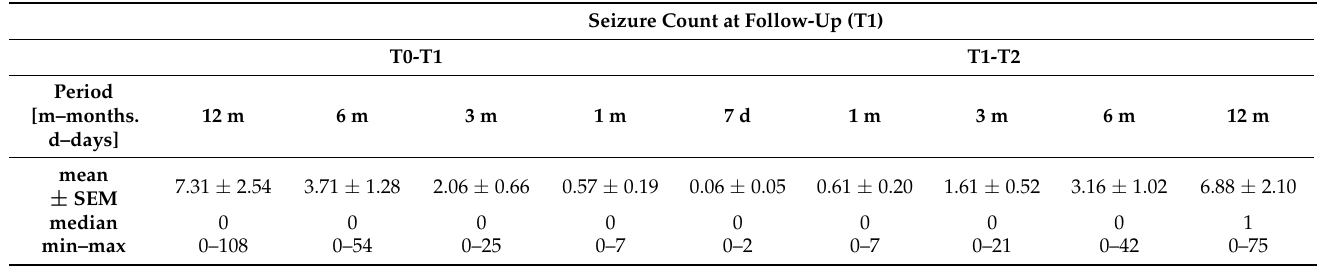
Table 5. Clinical characteristics of the patients–seizure count at follow-up.